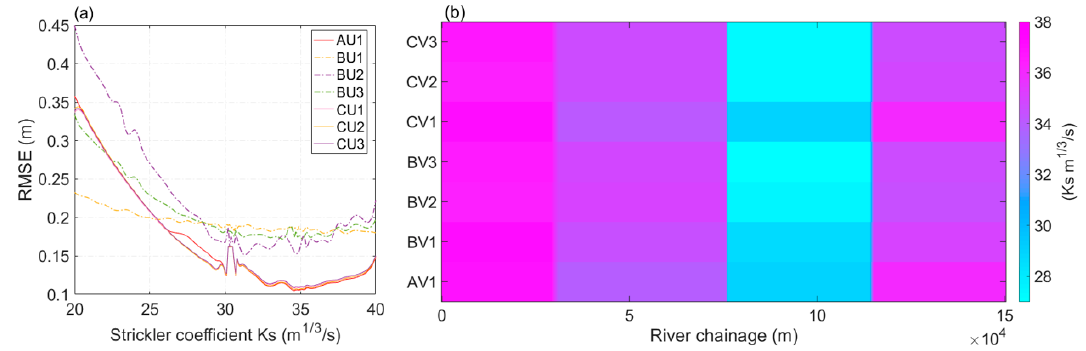
Figure 3. Calibration results of Strickler coefficients Ks for all schemes. ( a ) The sensitivity of the single Strickler coefficient Ks on model performance in terms of the root mean square error (RMSE). ( b ) The optimum values of variable Strickler coefficients Ks for different schemes.